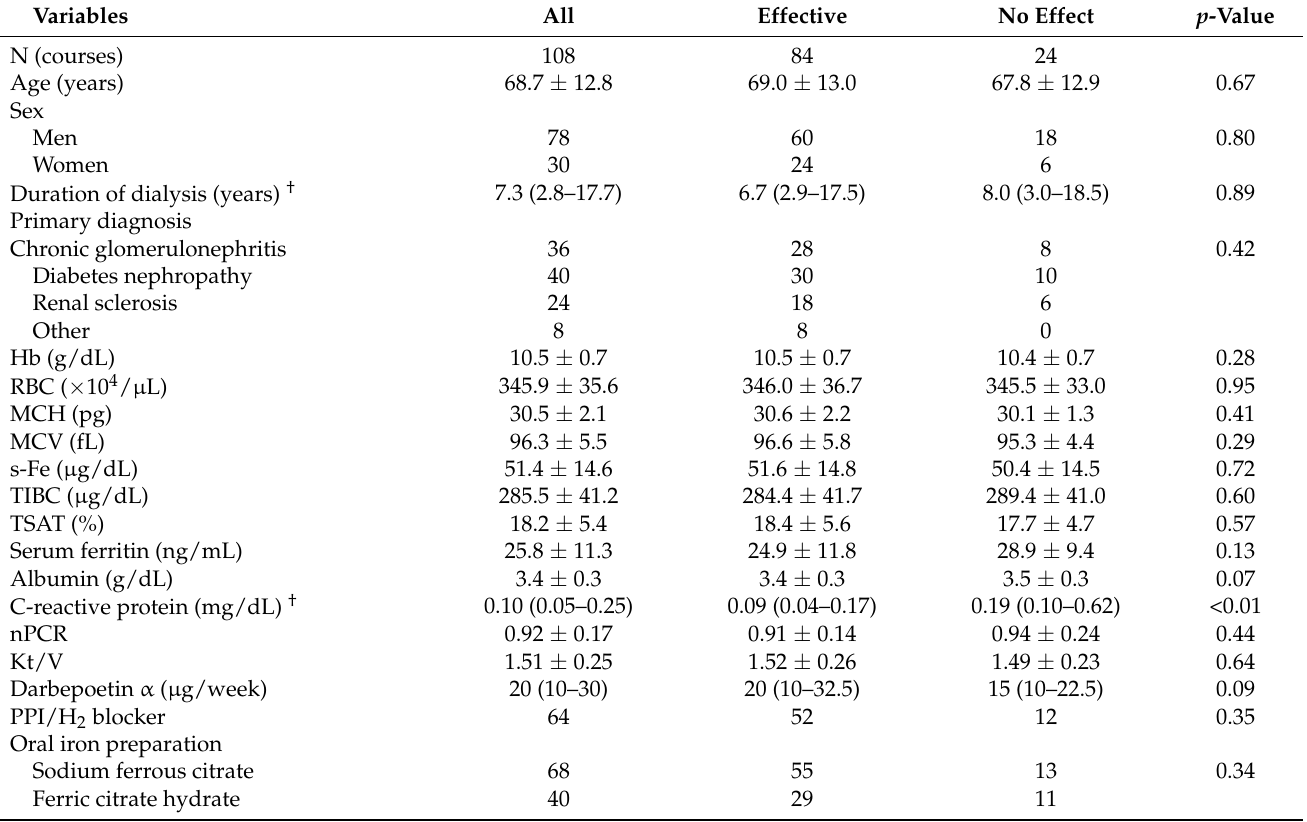
Table 1. Patient